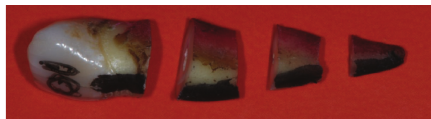
Figure1:Toothcutinto3sections:coronal,middle,andapicalusing an ultrafine cutting disc.